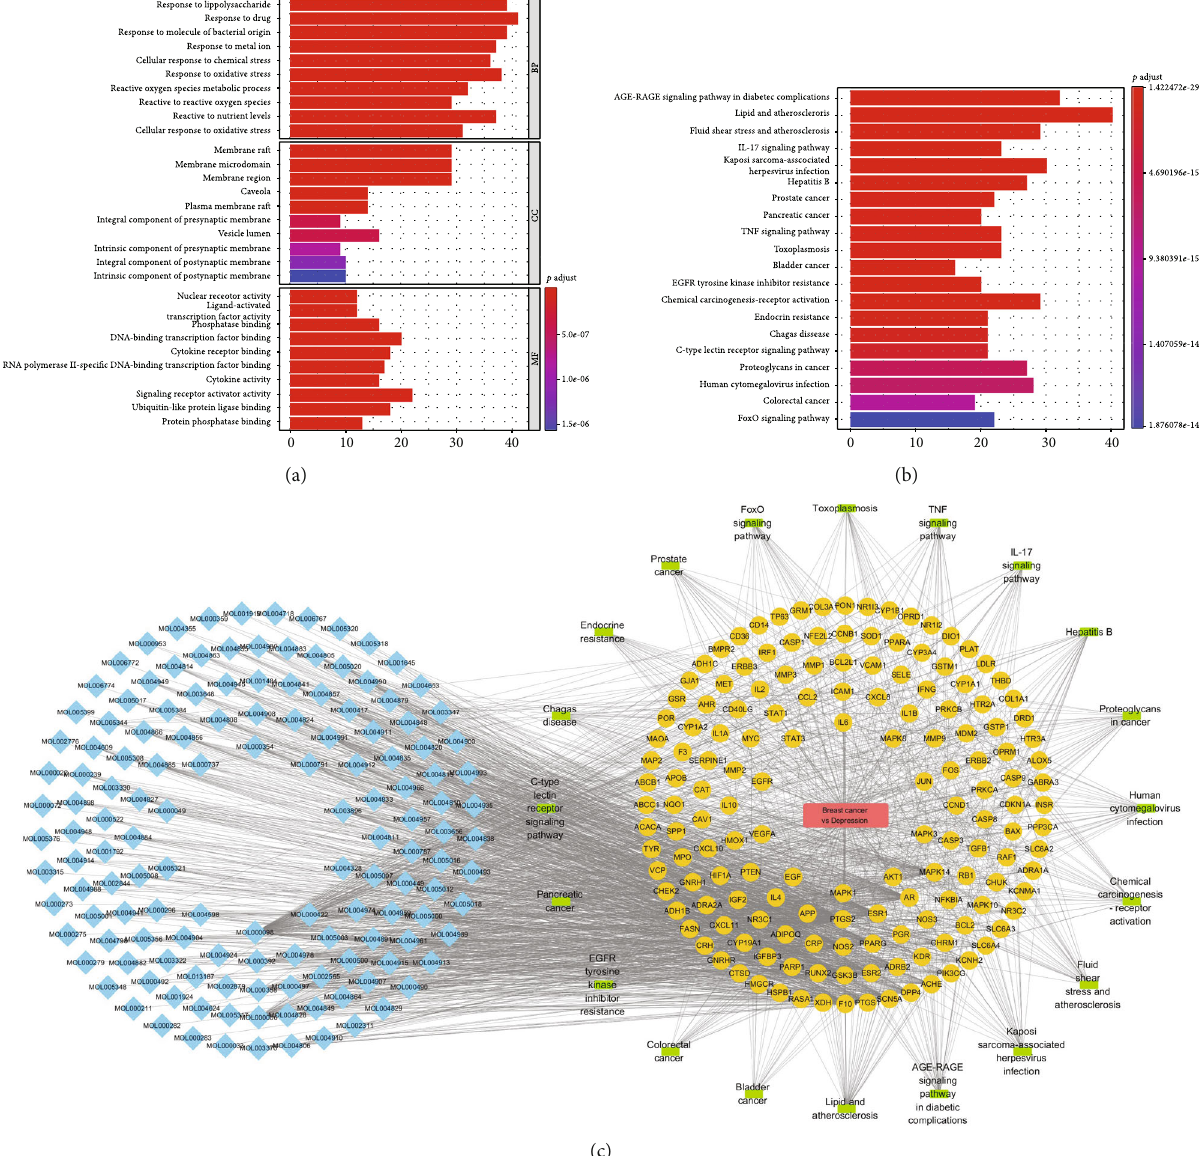
Figure 2: The GO data of enrichment and KEGG analysis. (a) GO analysis was performed to investigate the cellular biological process. (b) KEGG analysis was performed to investigate the most enriched pathways. (c) The network of